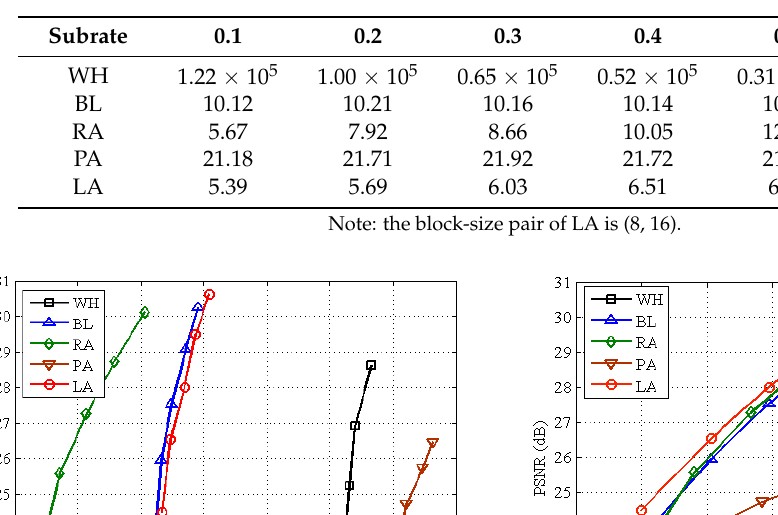
Table 3. Execution time (ms) of decoder for various measurement structures.